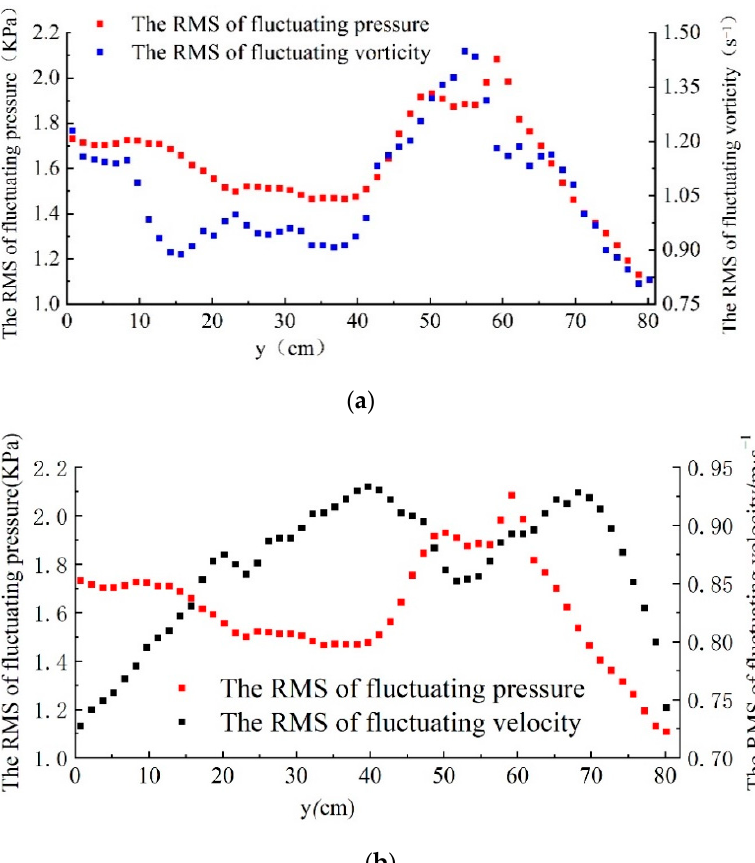
Figure 12. Distribution of root time-average square fluctuating pressure of x = 50 cm cross-section of bottom plate: ( a ) Distributions of fluctuating velocity and fluctuating pressure; ( b ) Distributions of fluctuating vorticity and fluctuating pressure.